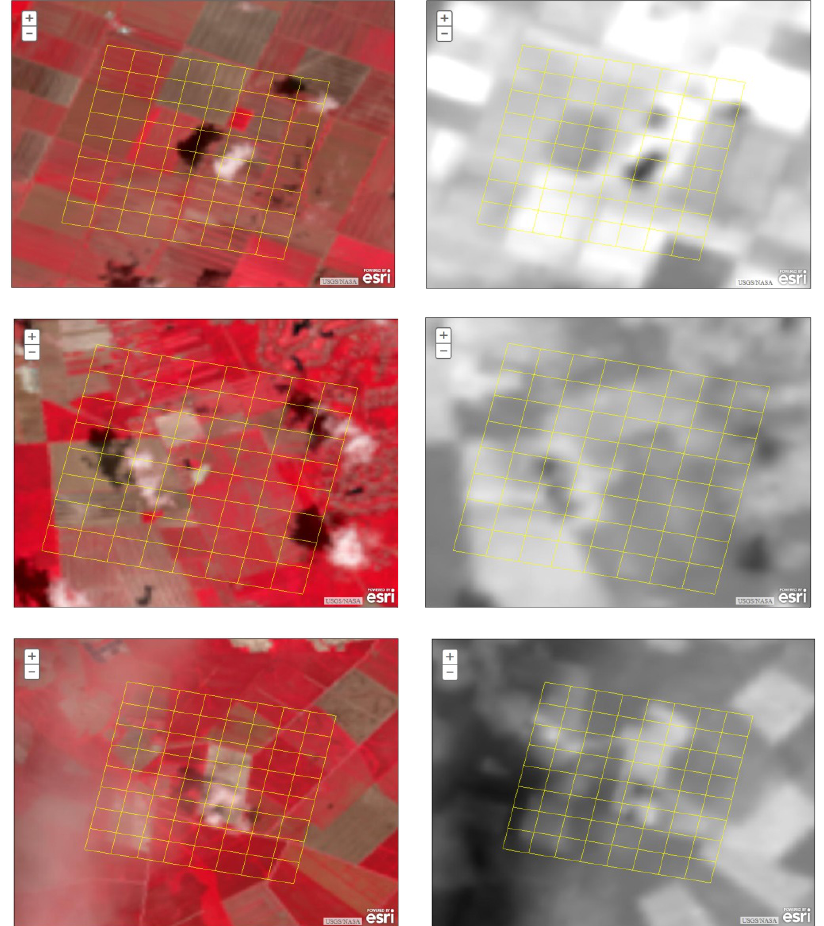
Figure 1. Landsat subsets for online experiment. First row: Easy image, second row: Medium image, third row: Difficult image. Left column: Infrared mode, right column: Thermal mode. Plus/minus zoom button shown in upper left hand